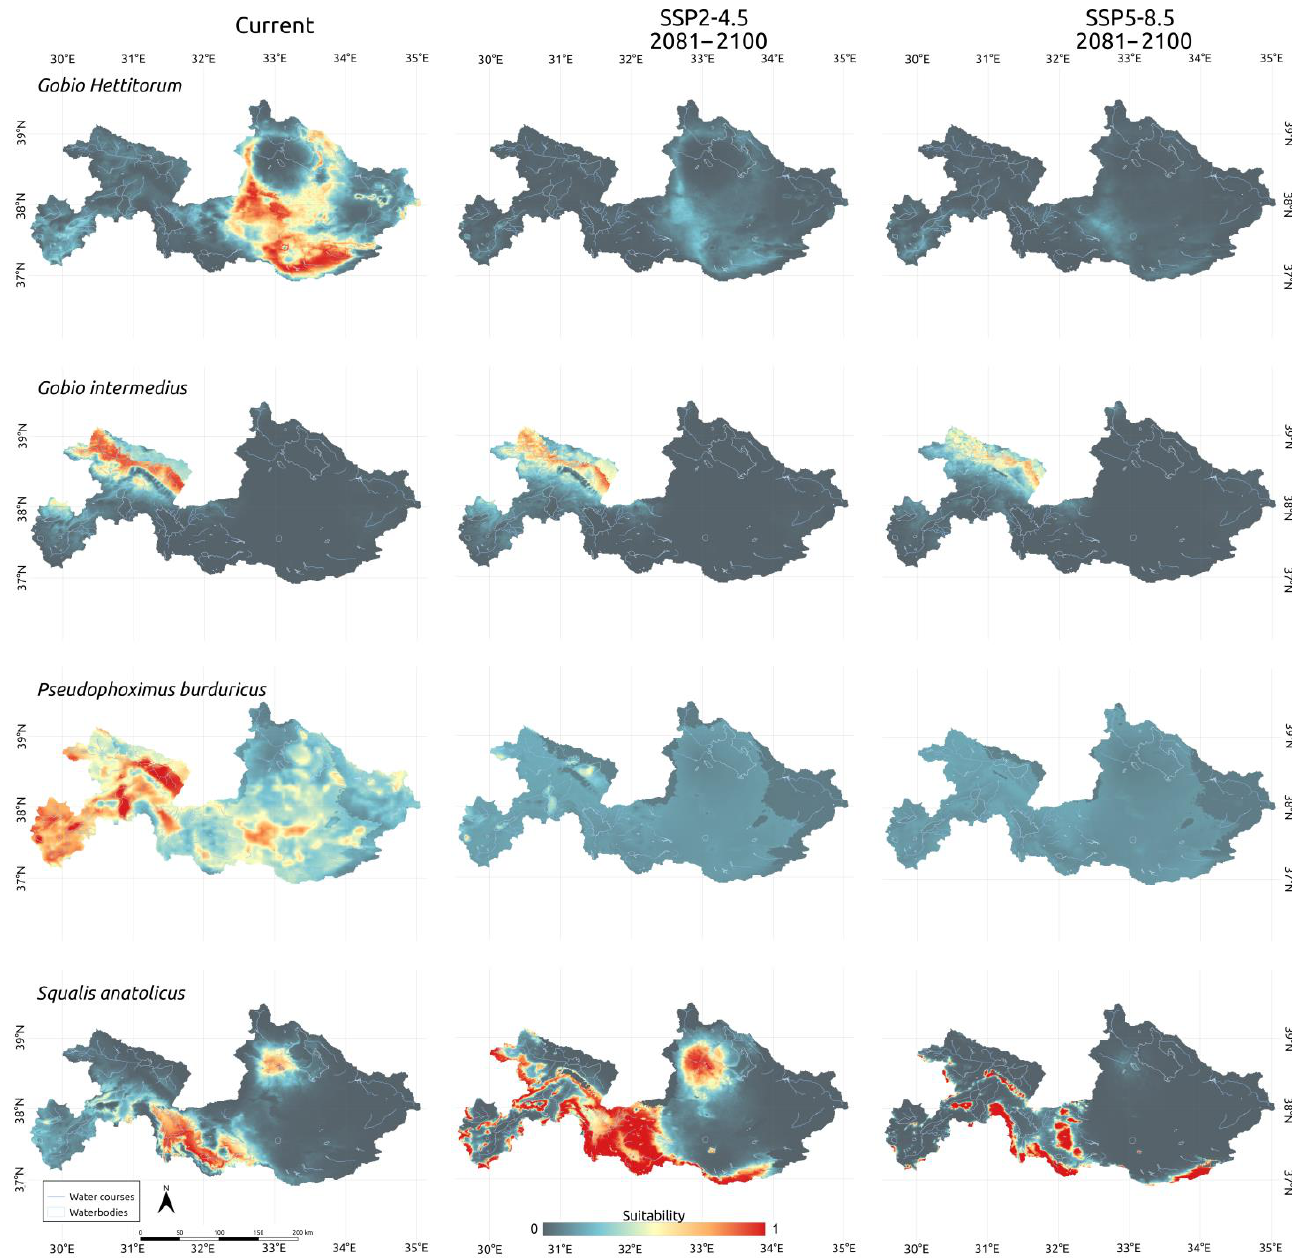
Figure 3. Current and future distribution of Gobio hettitorum , Gobio intermedius , Pseudophoxinus burduricus , and Squalius anatolicus in the CAE. Colours show habitat suitability, and the value of suitability increases in red areas.